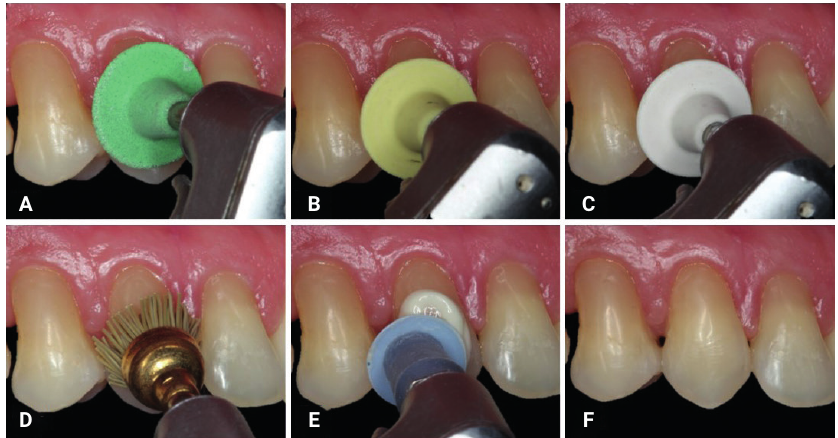
Figure 5. Finishing and polishing procedures. (a, b and c) Finishing with abrasive rubbers. (d) polishing with silicon carbide brush. (e) polishing with paste on felt disk. (f) Final aspect of